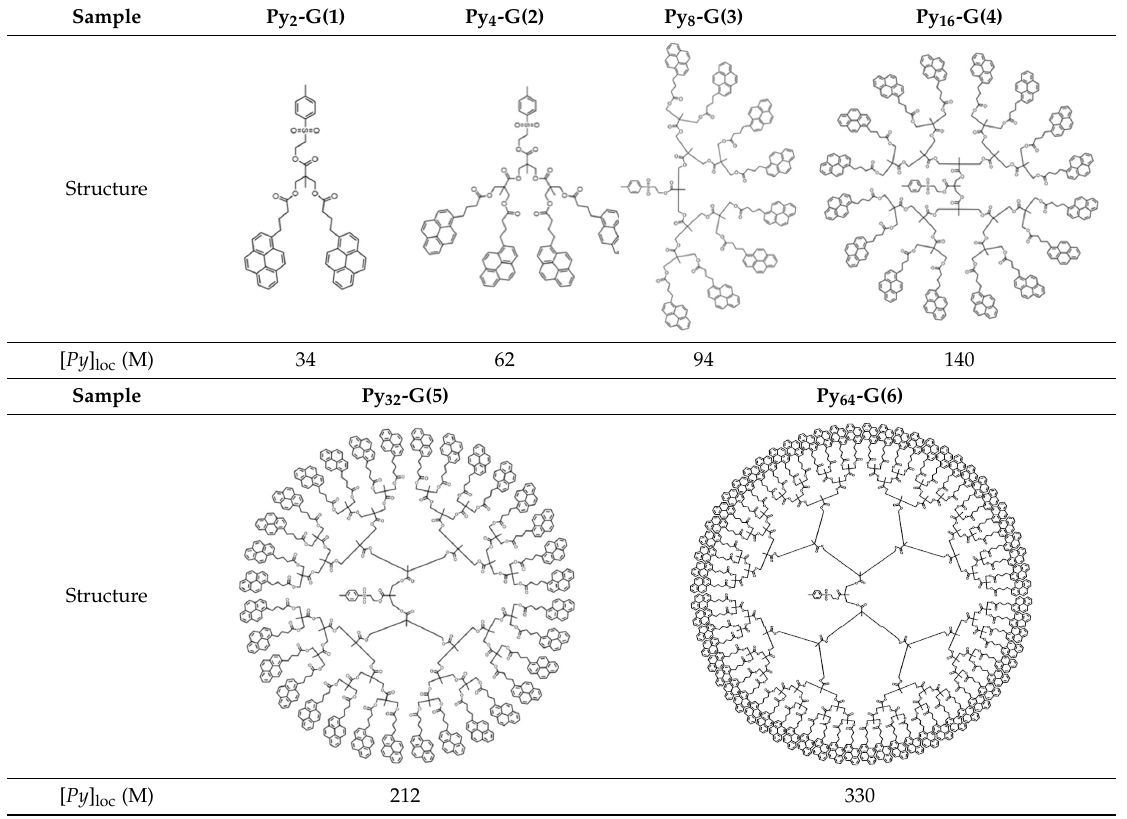
Table 1. Chemical structure and [ Py ] loc for each Py x -G( N ) dendron [29].